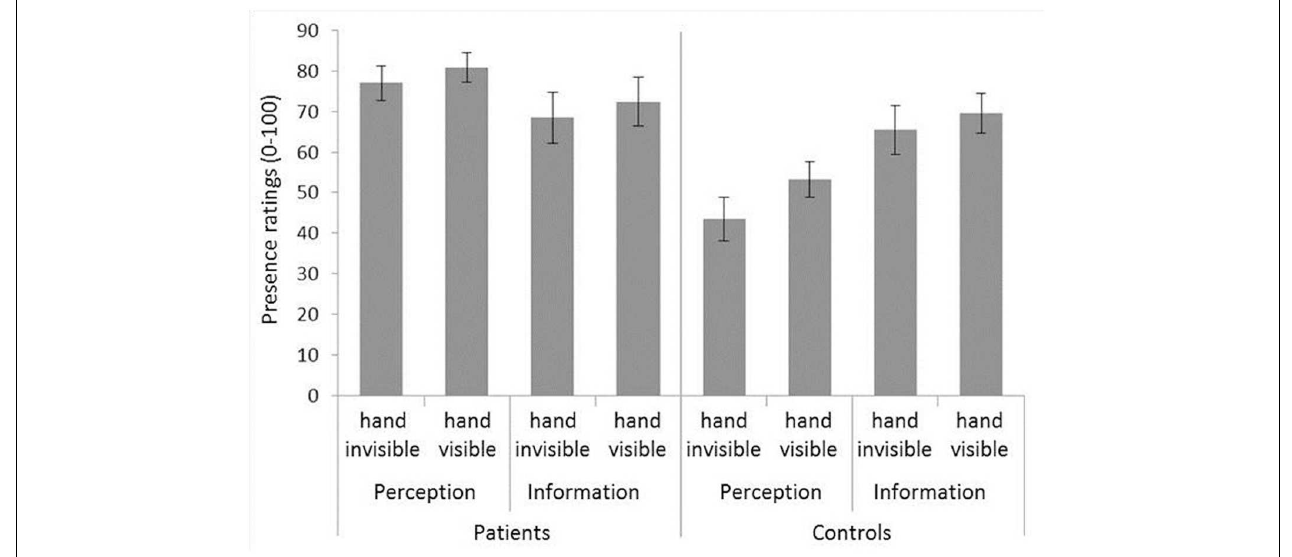
FIGURE 3 | Presence ratings. Mean of all trials is shown. Error bars represent standard errors of the